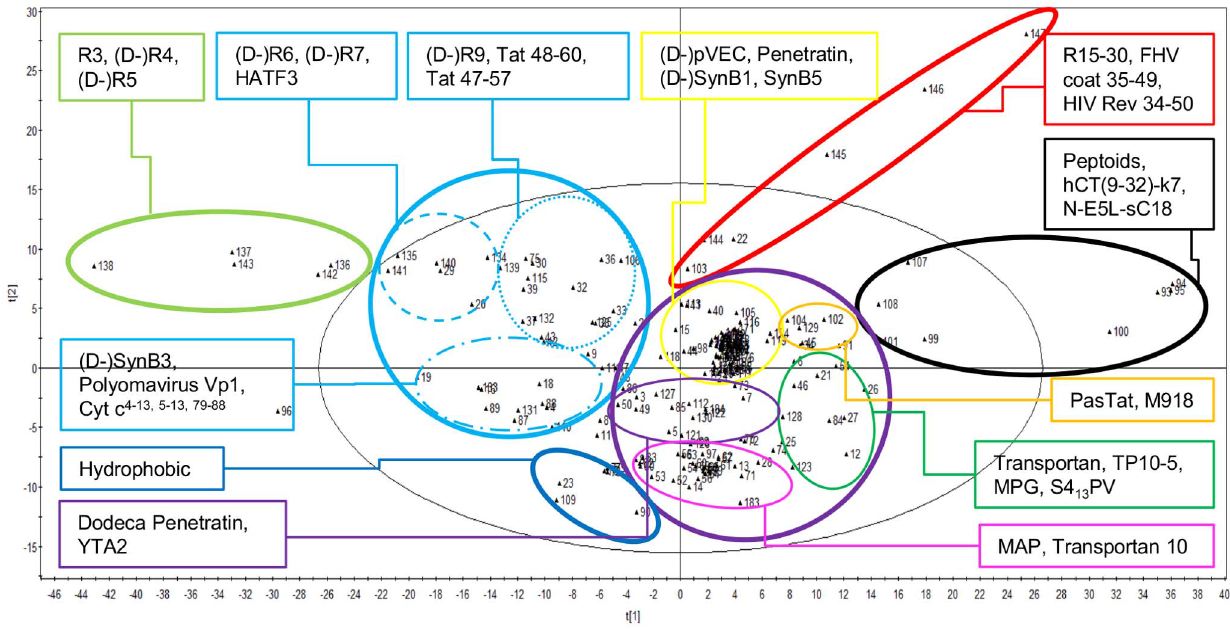
Figure 2. Score plot of the first versus the second principal component of the PCA-analysis of 186 peptides. The six main clusters of peptides are indicated by a bold line (light green, light blue, red, purple, black and dark blue clusters), while the eight subclusters are encircled by a thin line (light blue dashed and/or dotted line, yellow, orange, dark green, purple and pink clusters). For each cluster, some examples of peptides are indicated.